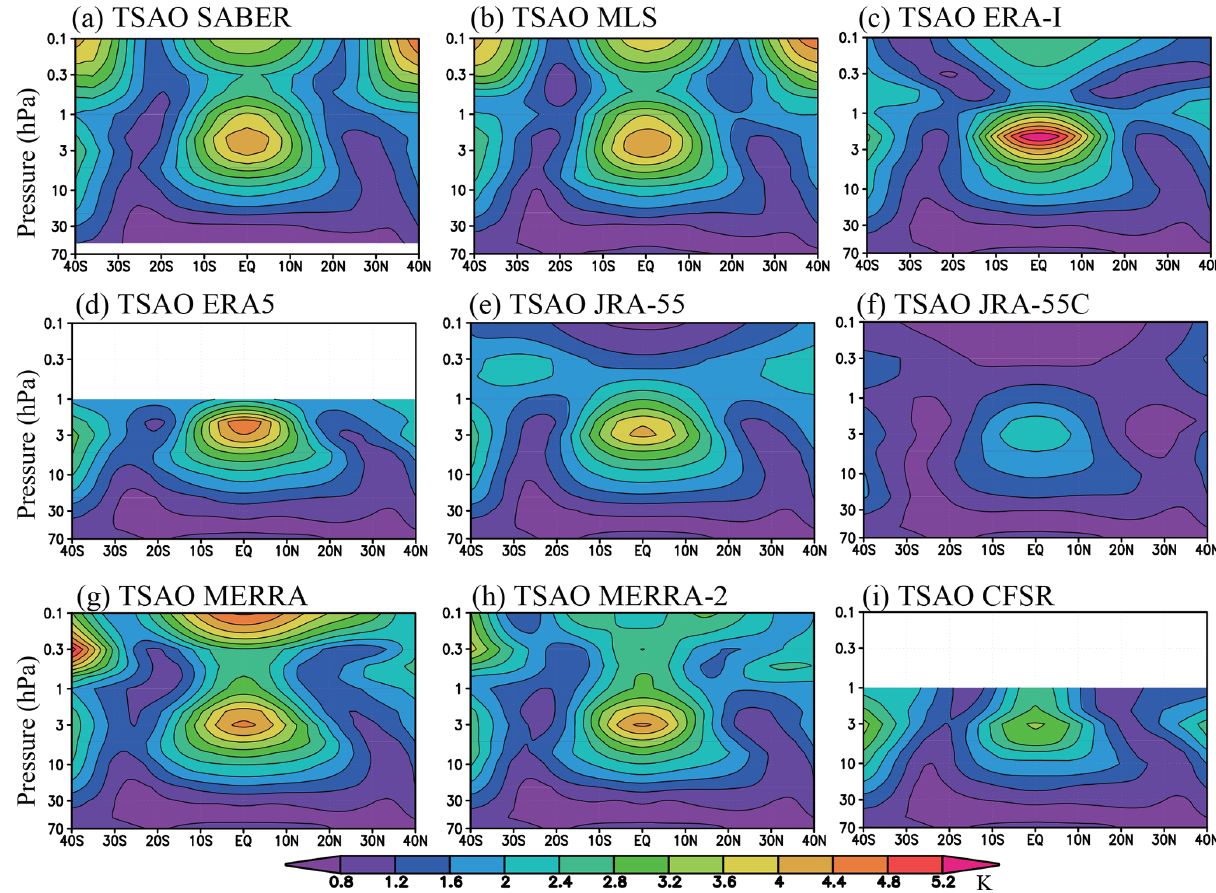
Figure 12. The same as Fig. 11 but for the SAO in temperature. Color intervals are